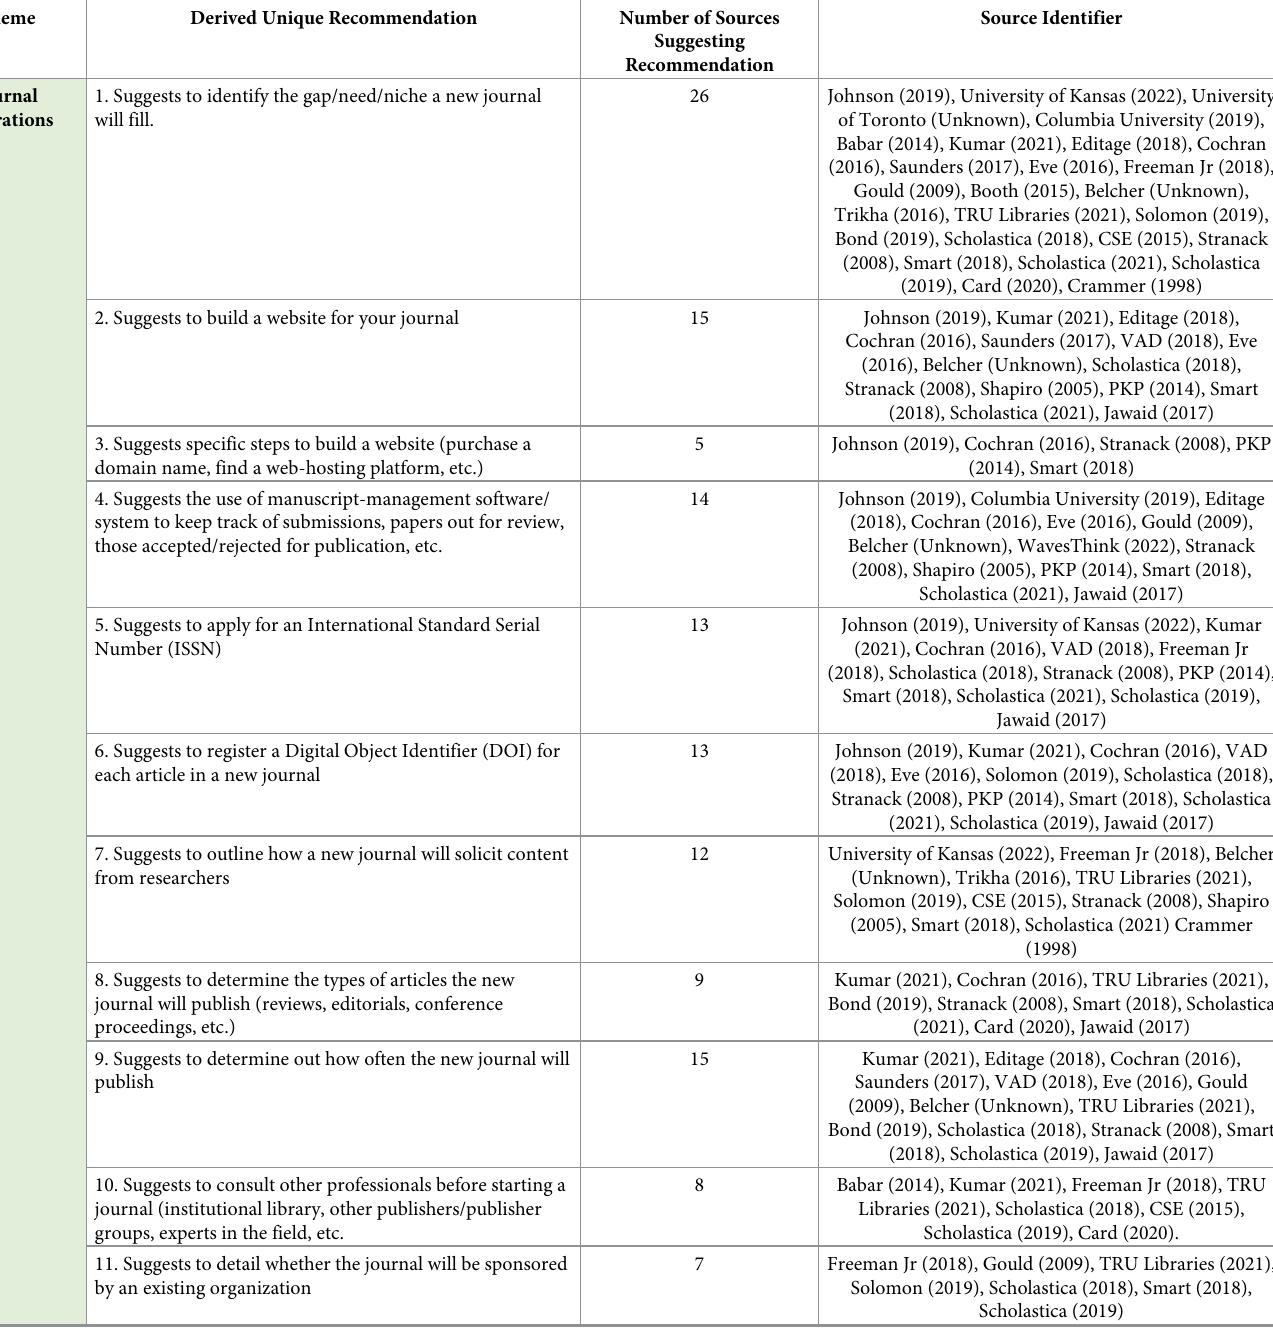
Table 7. All extracted recommendations regarding new scholarly journal creation from all included sources, categorized by source reference, theme, the unique rec- ommendation found, and the total number of sources suggesting the unique